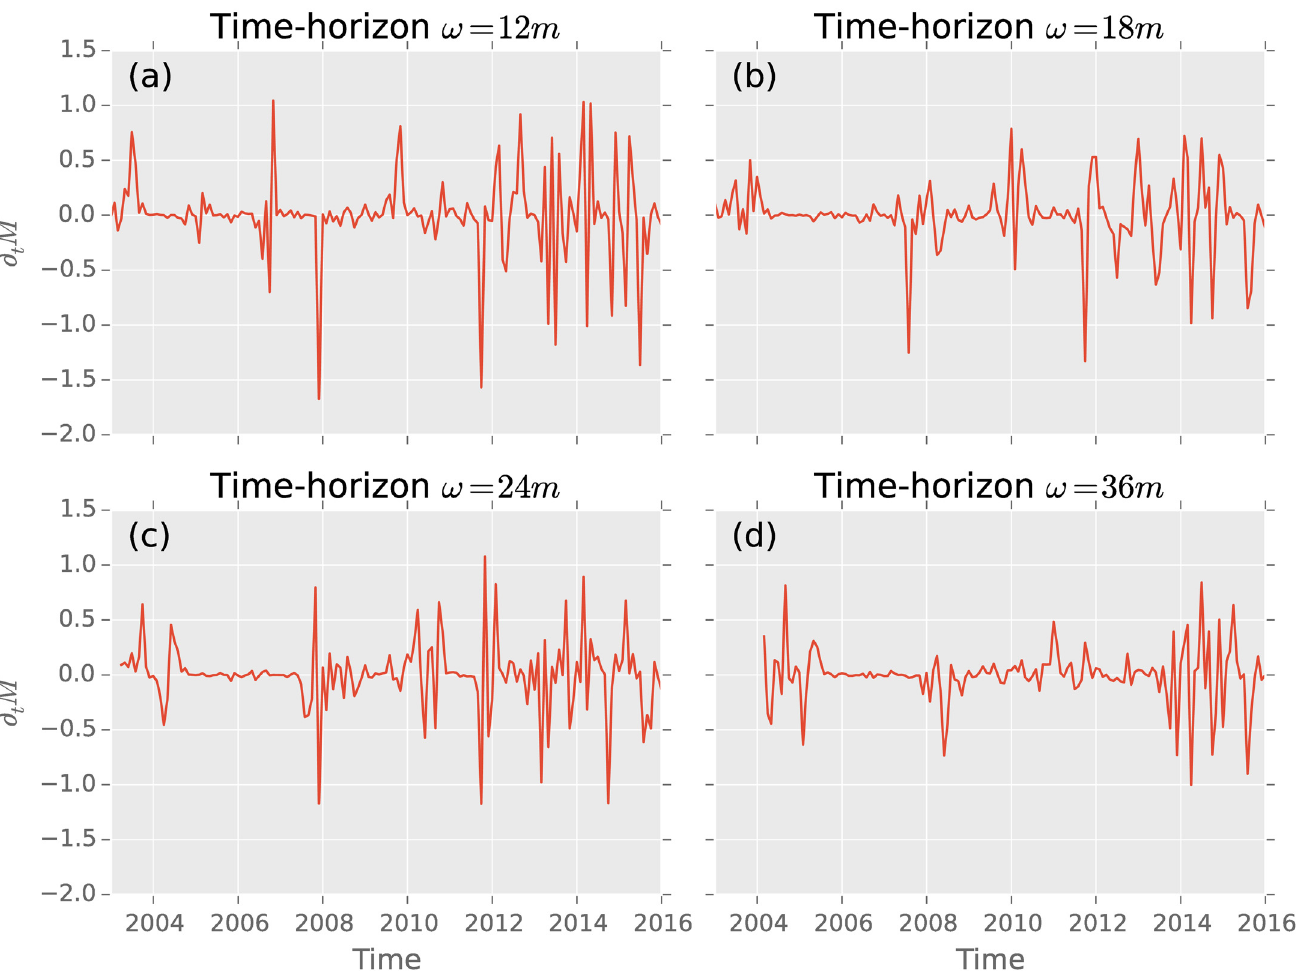
signals mix and the decreases are not highly developed. Especially since 2013 volatility clustering is